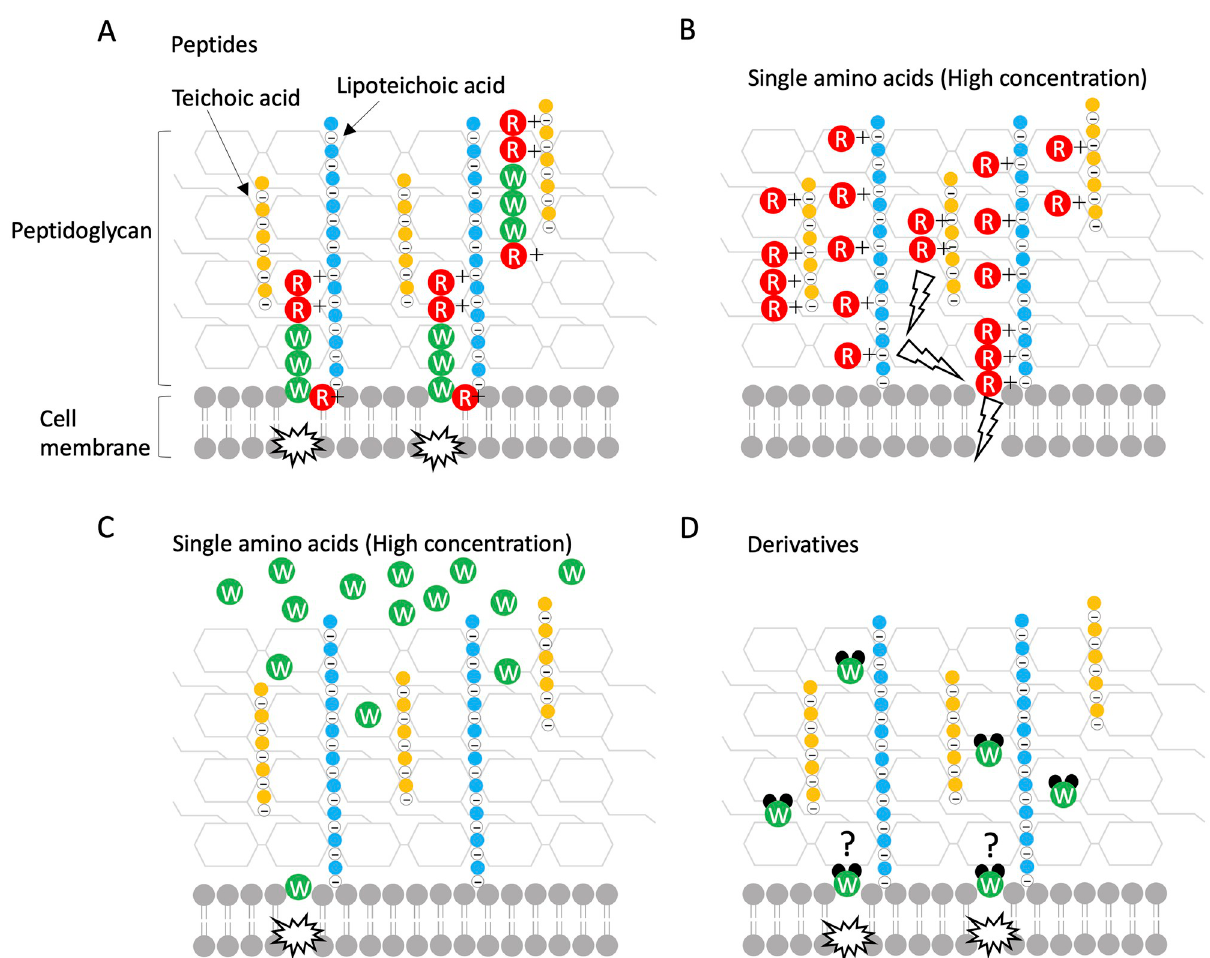
Fig 8. Schematic illustration of the speculated mechanisms for the antimicrobial activities of synthetic peptides, single amino acids, and derivatives against Streptomyces scabiei S58. (A) The peptide containing Arg and Trp residues is carried by the cationic Arg residue to the negatively charged bacterial cell surface (teichoic and lipoteichoic acids), and subsequently, Trp residue penetrates the interface layer of the membrane. (B) At a high concentration, cationic Arg may cover the entire negatively charged cell surface and cause an electric potential difference across the membrane, leading to membrane destabilization. (C) Trp, even at a high concentration, cannot effectively reach the cell surface because it is not positively charged. Only a few numbers reach the surface. (D) Trp derivatives may be able to effectively bind to the cell surface without a carrier, such as Arg residues. The change in the chemical structure of Trp may affect its binding